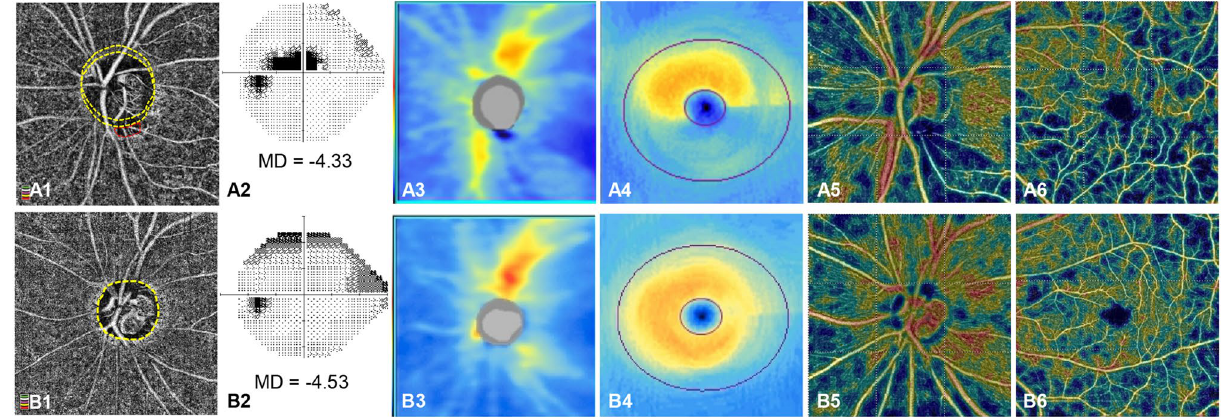
Figure 2. Representative cases ( A,B ) of open-angle glaucoma (OAG) eyes with and without choroidal microvasculature dropout (CMvD) showing different clinical characteristics. In the En face parapapillary choroidal layer image from optical coherence tomography angiography (OCT-A) analysis of OAG eye with CMvD ( A1 ) and that of OAG eye without CMvD ( B1 ), yellow and red dot outlines indicate the optic nerve head and CMvD borders, respectively. The CMvD+ eye showed a central visual field (VF) defect ( A2 ) with a VF mean deviation (MD) of − 4.33 decibel (dB), whereas the CMvD− eye showed a peripheral VF defect ( B2 ) with a similar VF MD of − 4.53 dB. On the spectral-domain optical coherence tomography (SD-OCT) thickness map, the CMvD+ eye showed localized circumpapillary retinal nerve fibre layer thickness (cpRNFLT) loss at the inferior temporal (IT) sector (50.5 μm) and at the temporal (T) sector (58.0 μm), which was adjacent to the site of the CMvD ( A3 ). The CMvD+ eye also revealed macular ganglion cell-inner plexiform layer (mGCIPL) thinning at the inferior hemiretina, including IT sector (57.3 μm, A4 ). On the color-coded OCT-A map, the circumpapillary vessel density (cpVD) reduction was detected at the IT region (23.7%, A5 ), while a macular vessel density (mVD) reduction (36.4%) was also observed at the inferior hemiretina ( A6 ). The CMvD− case ( B1 ), however, demonstrated a peripheral VF defect ( B2 ) with cpRNFLT loss at the IT sector (61.0 μm, B3 ), while there was less pronounced mGCIPL thinning at this sector (70.0 μm, B4 ). On the color-coded OCT-A map, despite the slight cpVD reduction detected at the IT region (39.7%, B5 ) where the cpRNFLT loss